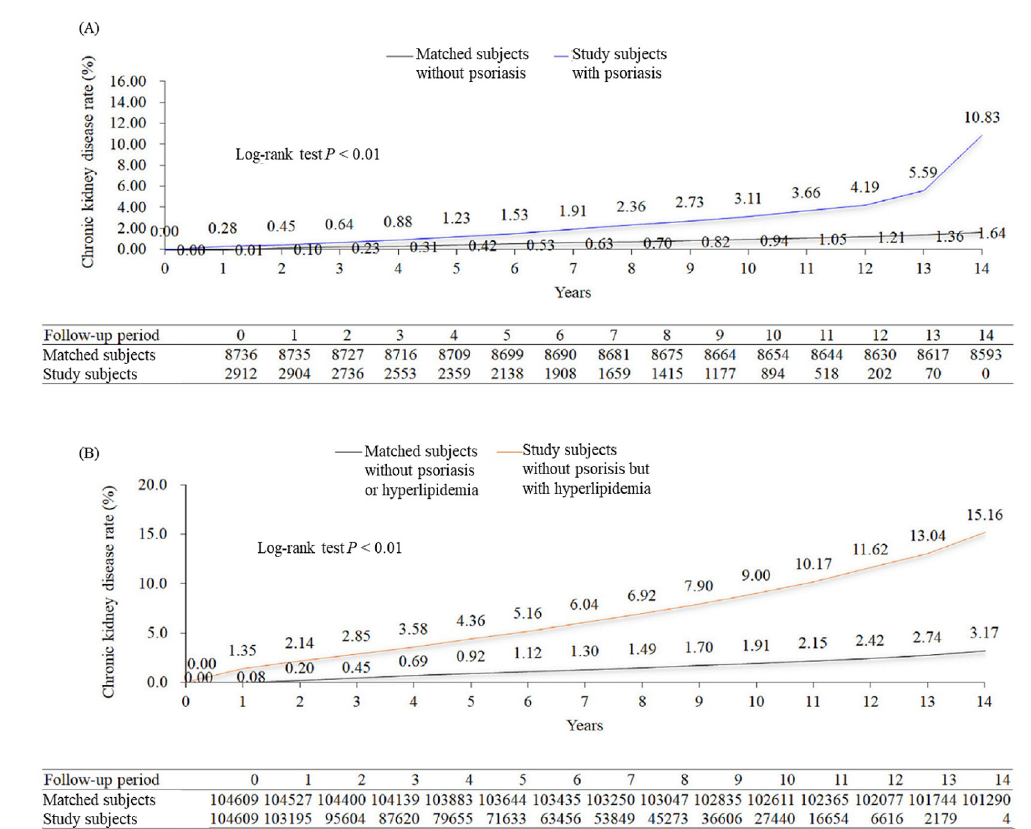
Fig 2. Cumulative incidences of chronic kidney disease in (A) the psoriasis cohort and (B) the hyperlipidemia cohort. Differences in the incidences of chronic kidney disease were compared using the log-rank test and Kaplan-Meier analysis. (Table 4). In patients without psoriasis, the adjusted RRs of CKD were 0.39 (95% CI, 0.32–